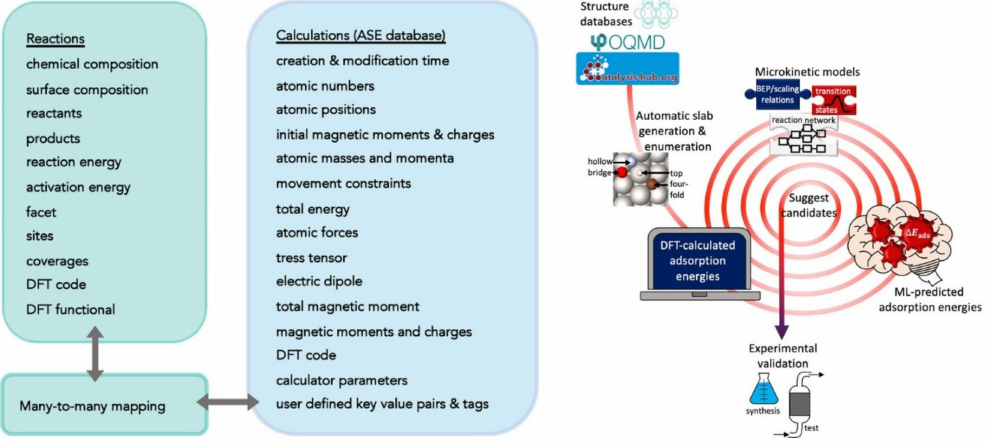
Figure 1. Left: Schematic of the SQL data structure of Catalysis-Hub.org, used to store reaction energies (reactions table, green) and DFT calculations (ASE database, blue). Since each reaction energy involves several DFT calculations (and the same DFT calculations can potentially be used for several reactions), a many-to-many mapping schema is used to preserve connections between the table rows. Right: Machine learning-enhanced catalyst candidate prediction: bulk and surface structures retrieved from structure databases like materialsproject.org, OQMD, Catalysis-Hub.org, etc., are used for automated slab generation and enumeration of possible adsorption sites. In an iterative process, limited numbers of DFT-calculated adsorption energies and machine-learning-predicted adsorption energies are used to inform microkinetic models to eventually suggest promising catalyst candidates that should be investigated by experiment. Adapted with permission from [26]. Copyright